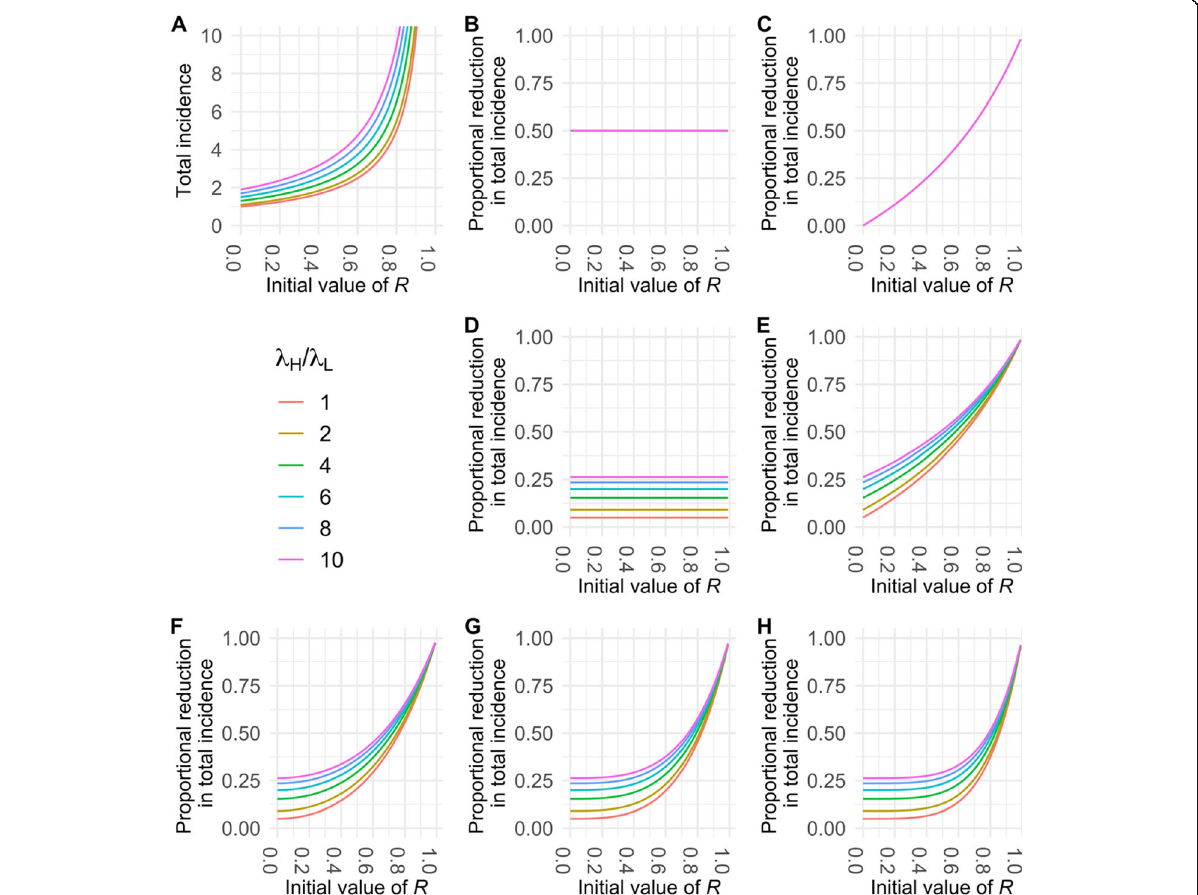
Fig. 6 Impacts of different control measures on the total incidence of a zoonotic infection with R (before control) between 0 and 1 with a varying ratio of high and low spillover rates. Panel a shows how total incidence increases with R for varying ratios of high-to-low zoonotic spillover. Panels b - e illustrate proportional reduction in incidence for controls that would cause 50% reductions in all spillover transmission ( b ), human-to-human transmission ( c ), spillover transmission into the high-risk group ( d ), or jointly high-risk spillover and human-to-human transmission ( e ). Panels f - h show the proportional reduction in incidence given a reactive strategy that first targets high-risk spillover and then switches to reducing human-to-human transmission after 1, 2, or 3 generations of transmission, respectively. Note that longer delays cause the results to resemble Panel d over increasing ranges of R values, since at low R many transmission chains don ’ t last multiple generations. The proportion of high-risk individuals in the population was set to